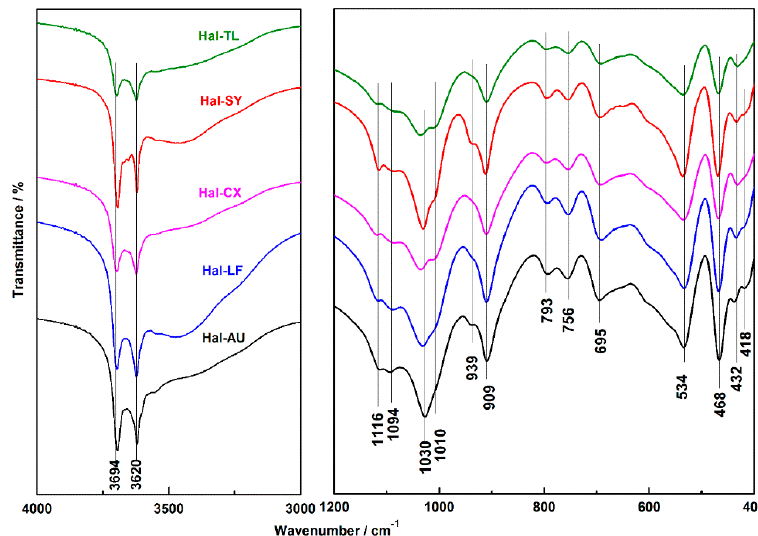
Figure 2. FTIR spectra of different halloysite minerals in the range 3000–4000 cm − 1 and 400–1200 cm − 1 .